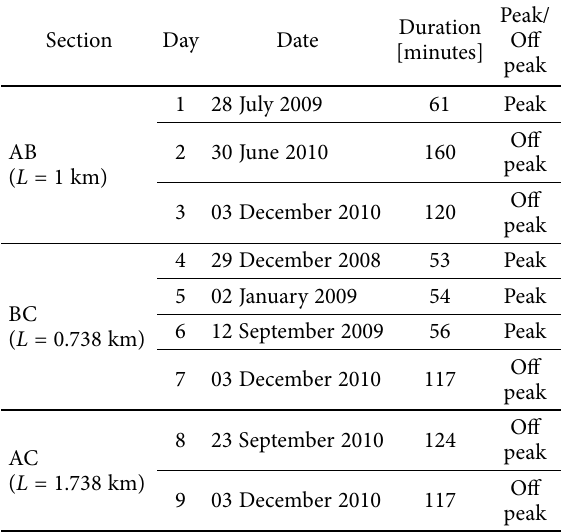
Table 3. Details of data collection for implementation and corroboration of estimation schemes Section